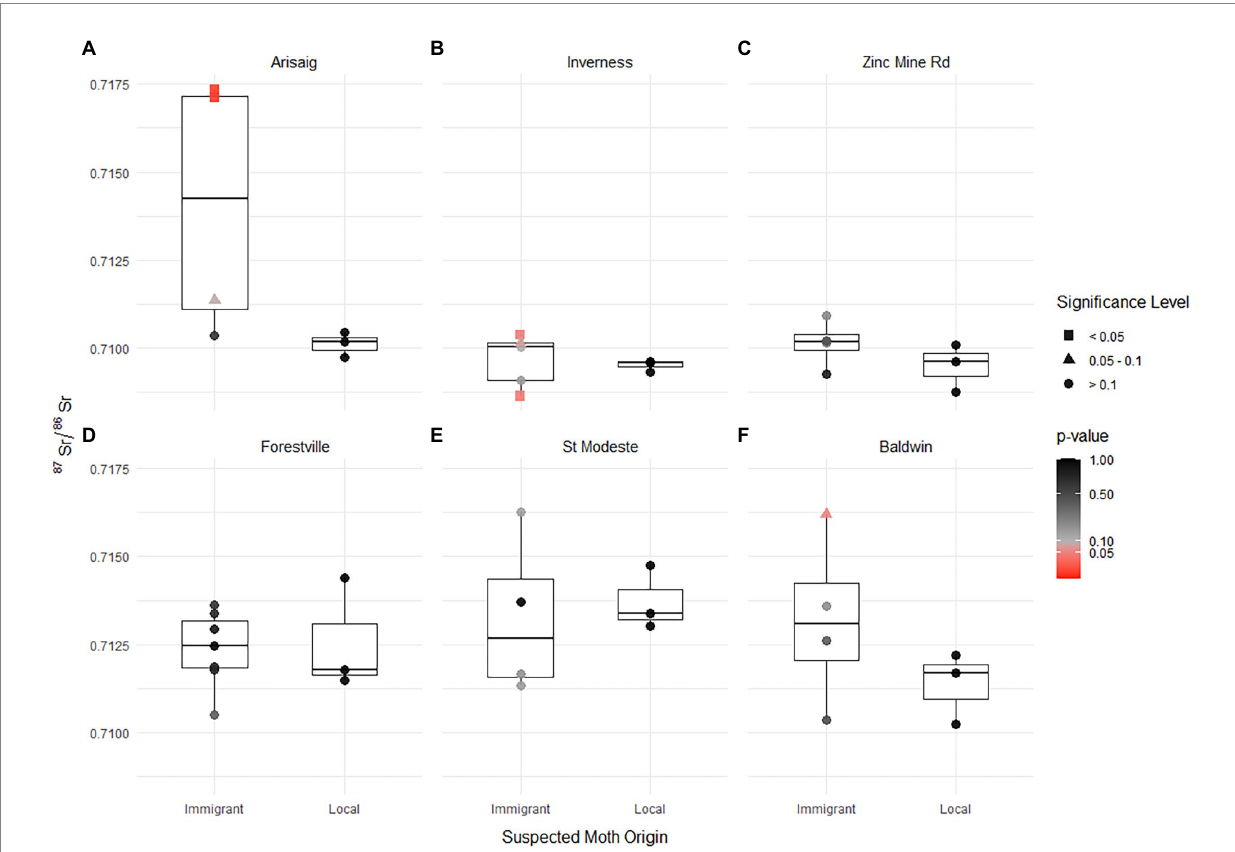
FIGURE 4 Box and whisker plot of 87 Sr/ 86 Sr ratios for immigrant and local spruce budworm individuals by sampling site (population, A–F ). Local individuals are colored black, immigrant individual symbols represent whether they significantly differ from locals (squares; t -test; value of p < 0.05), were not significantly different (circles; t -test; value of p > 0.1) or were marginally non-significant (triangles; t -test; 0.105 > value of p > 0.05 <